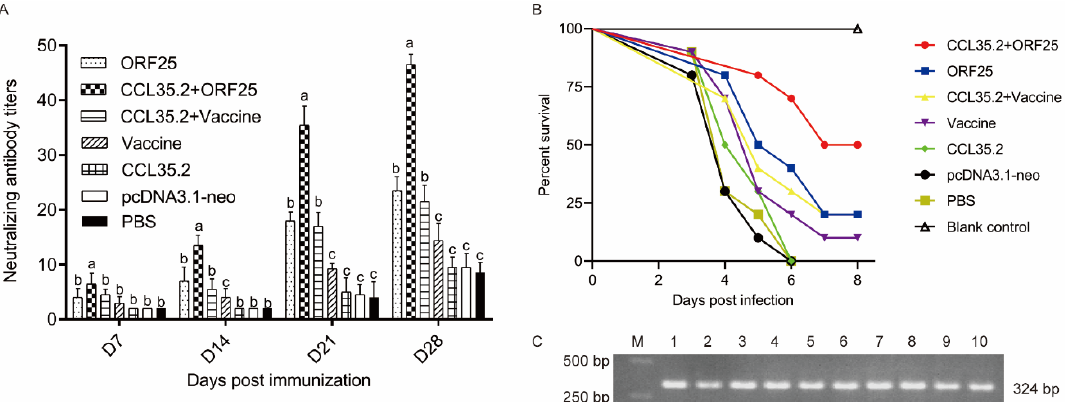
gene was used as an internal control gene. ( D ) Detection of serum antibody levels by ELISA in gibel Five animals were randomly selected and gathered serum on 14 dpi before virus challenge. 50 μL carp. Di ff erent superscript letters in each group (a–c) denote significant variations suggested by the virus (1 × 10 7 TCID 50 mL −1 ) was mixed and incubated with 50 μL serum (1:20) and injected into healthy Kruskal–Wallis statistics at 95% of significance, followed by the Dunn test with Bonferroni adjustment fish. In blank control, each fish was injected with 100 μL PBS without virus. as the post hoc test ( p < 0.05).